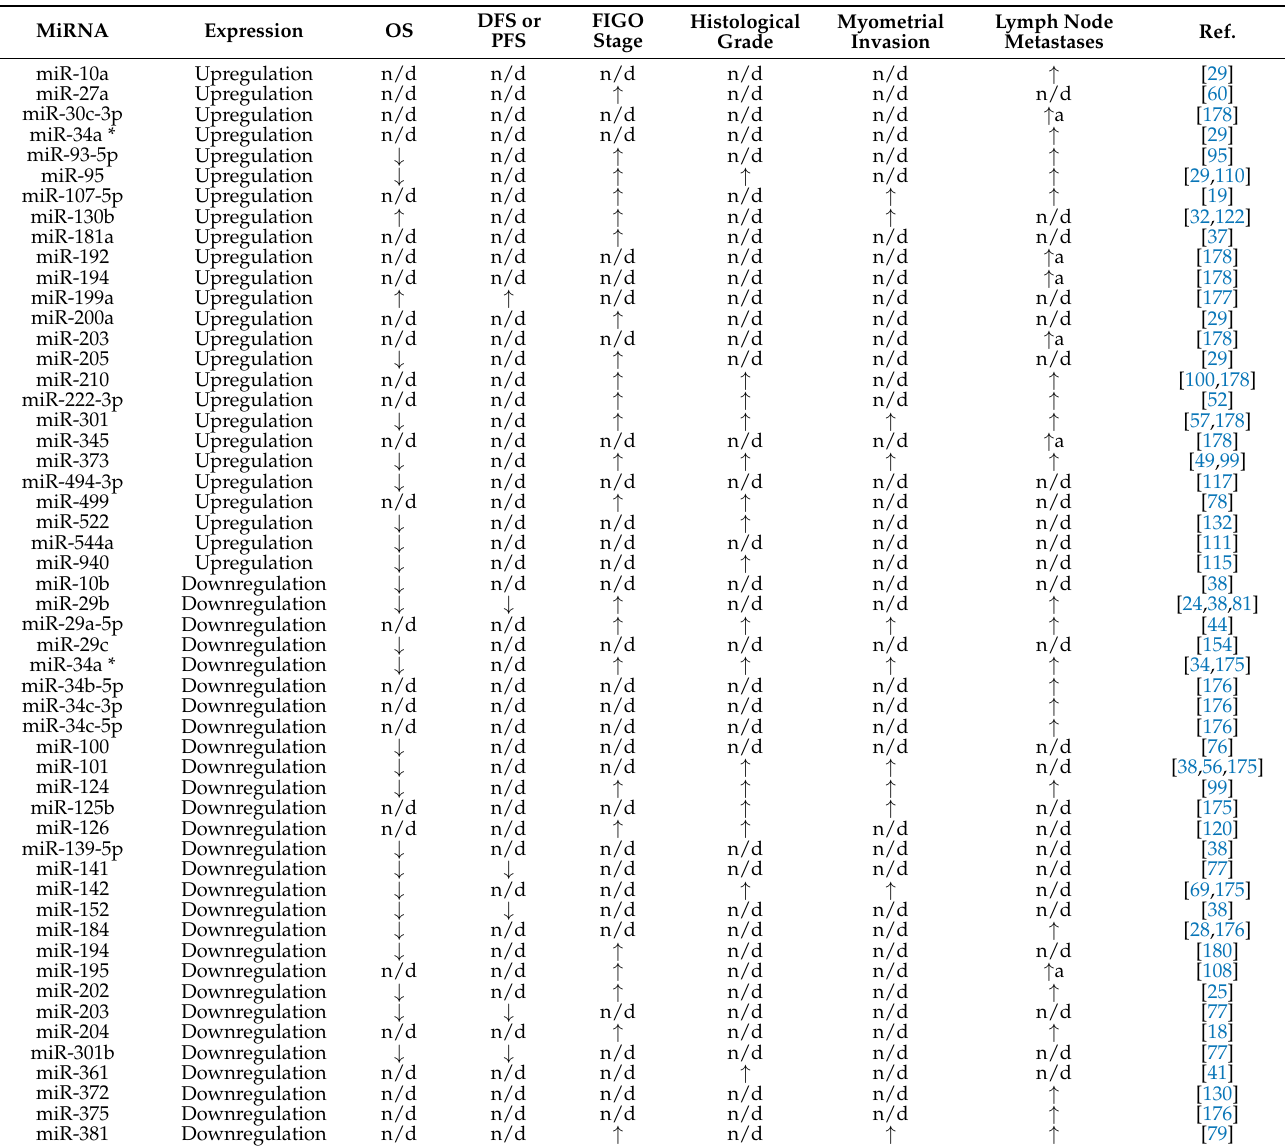
Table 4. The correlation of miRNA expression and clinical